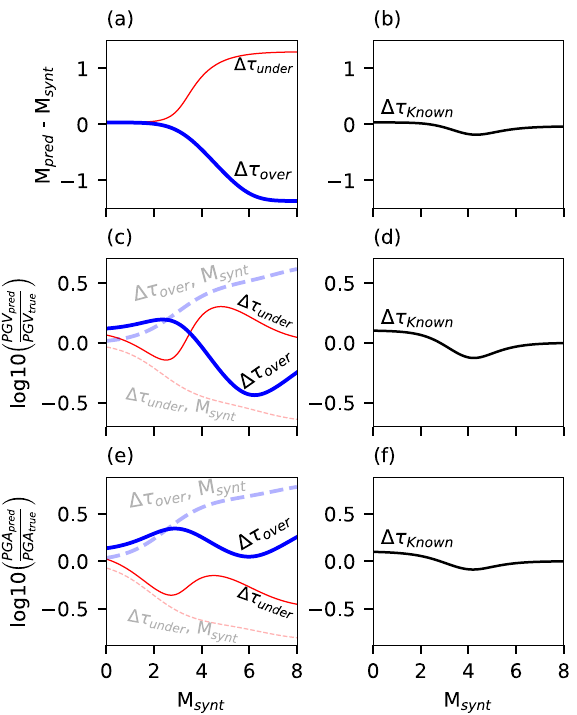
Figure 3. The effect of stress drop variability on magnitude estimation and ground motion prediction. Estimated minus synthetic magnitude as a function of synthetic magnitude for ( a ) under-estimated (1 MPa), over-estimated (100 MPa) and ( b ) known (10 MPa) stress drops. The logarithms of predicted peak ground motions minus the logarithms of synthetic peak ground motions as functions of synthetic magnitude are shown for PGV for ( c ) 1 MPa and 100 MPa and ( d ) 10 MPa, and for PGA for ( e ) 1 MPa and 100 MPa and ( f ) 10 MPa. The effect of using synthetic magnitude on ( c ) PGV and ( e ) PGA discrepancies is indicated by semi-transparent dashed curves. In all panels, curves corresponding to 1, 10 and 100 MPa are indicated by red, black and blue curves,